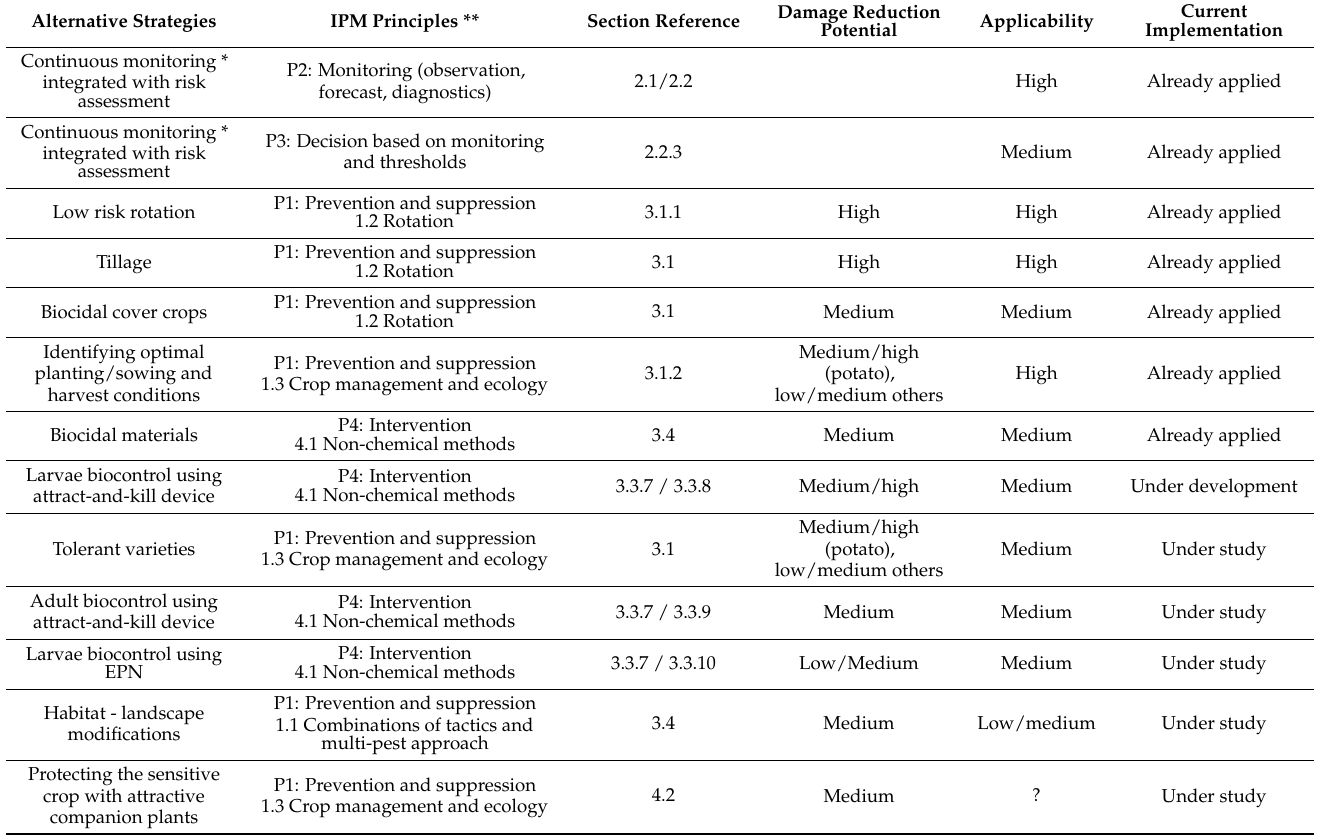
Table 3. Alternative strategies that can be applied to maintain wireworm density below damage thresholds according to results of continuous monitoring. One or more practices can progressively be applied to push back wireworm population levels. Under study: promising ongoing research but no or negligible practical implementation. Under development: limited practical applications; ongoing evaluations to adapt solution to variable practical conditions. Already applied: significant widespread